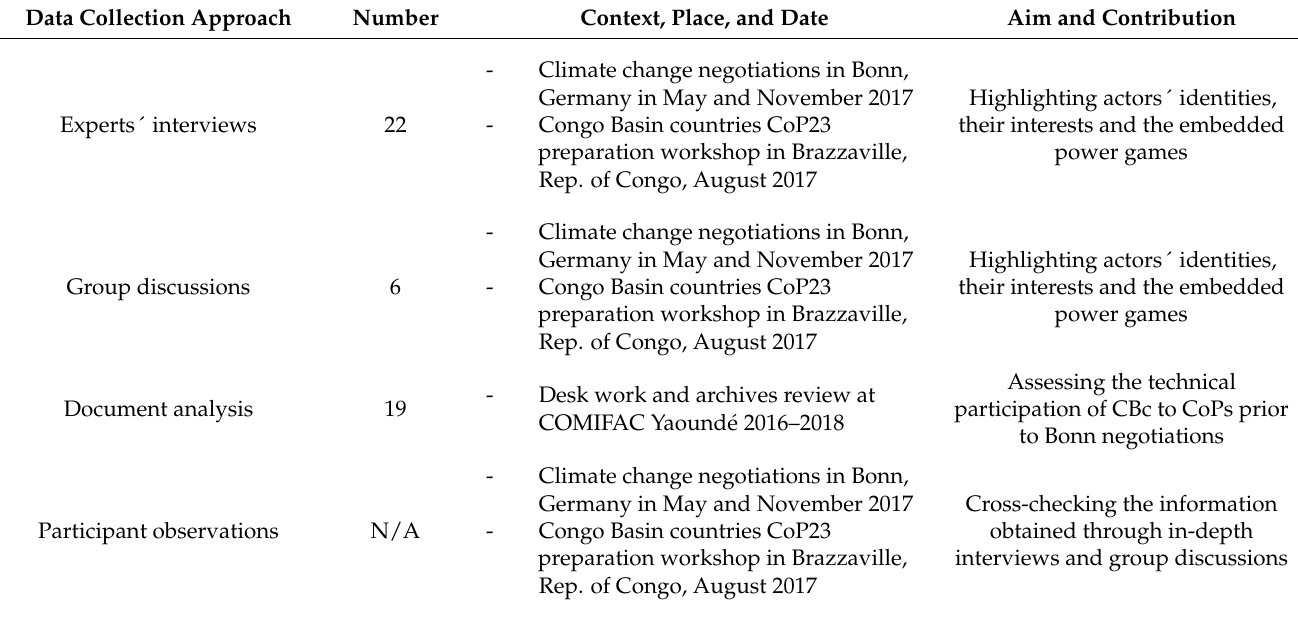
Table 1. Overview of empirical qualitative data